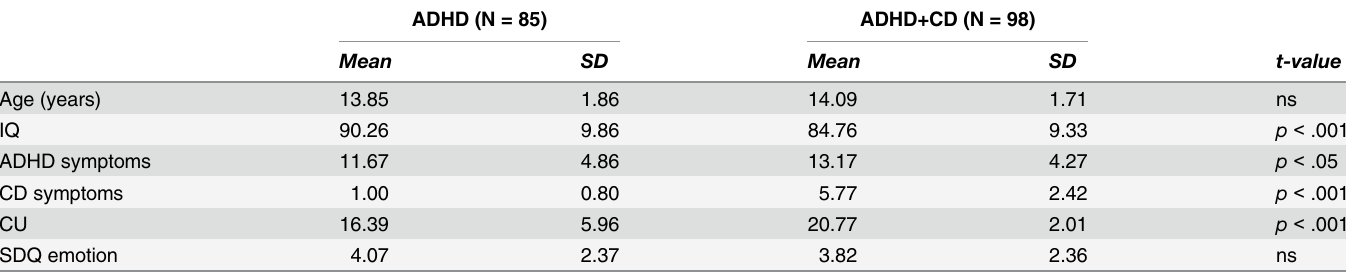
Table 1. Demographic and clinical characteristics of the ADHD and ADHD+CD subgroups.